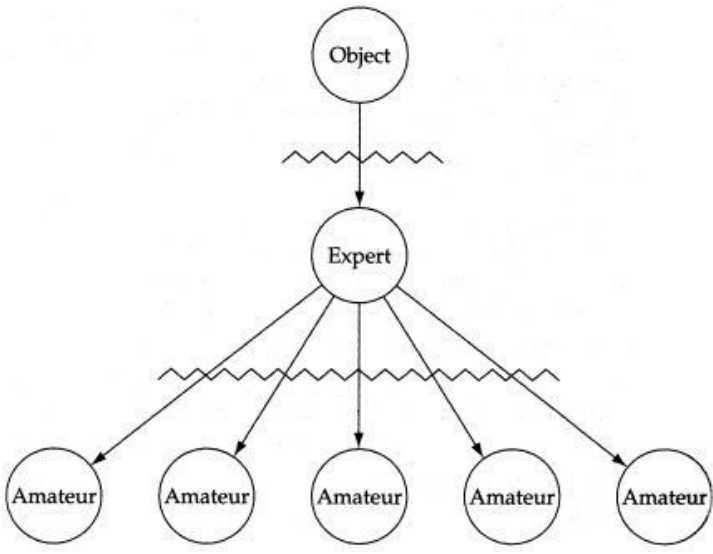
Figure 1. Parker Palmer on “Mythical Objectivism”.